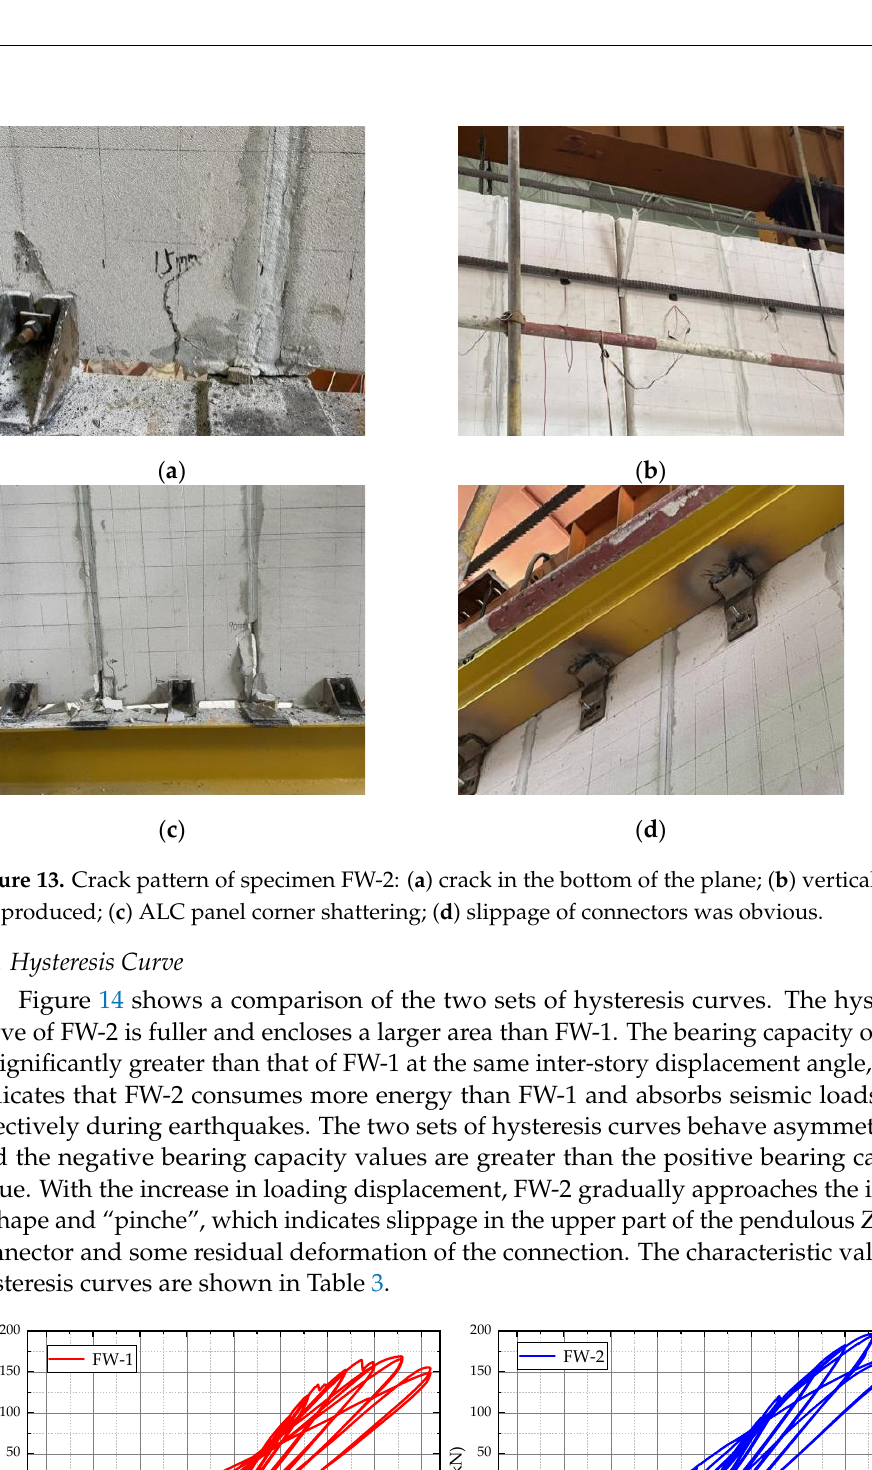
Table 3. Characteristic values on hysteresis curves.